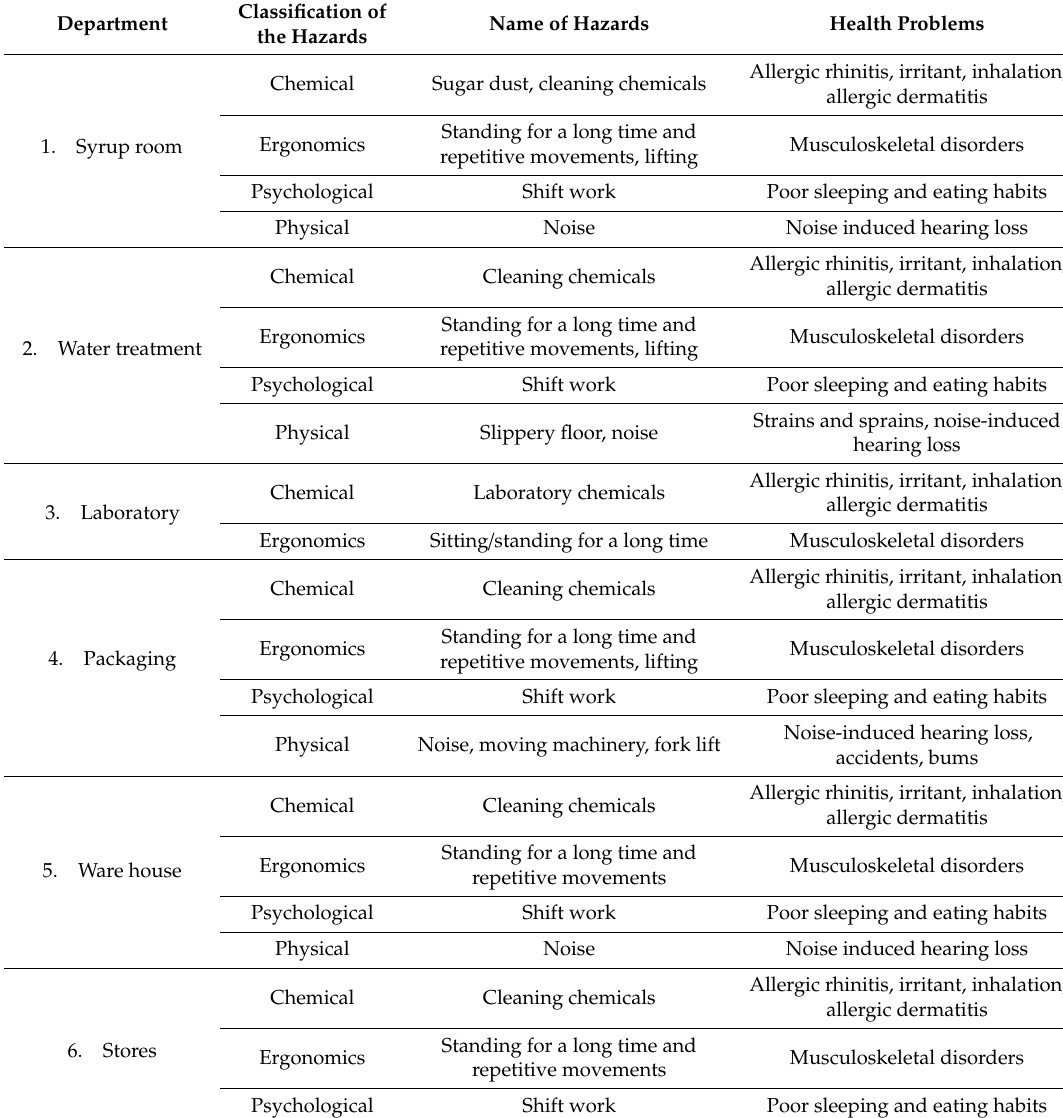
Table 1. Industry 1: Health Hazard types and classification per